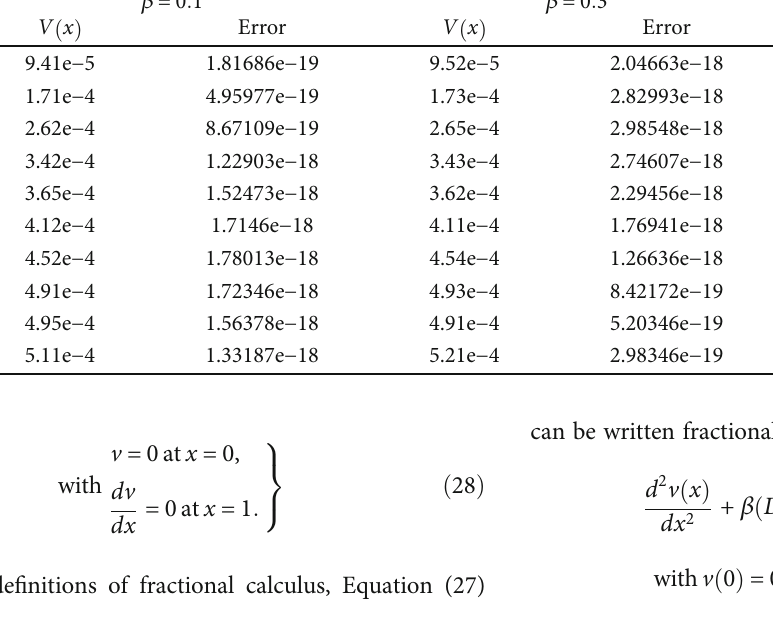
Table 6: Results for β in drainage case where α = 0 : 95 and g